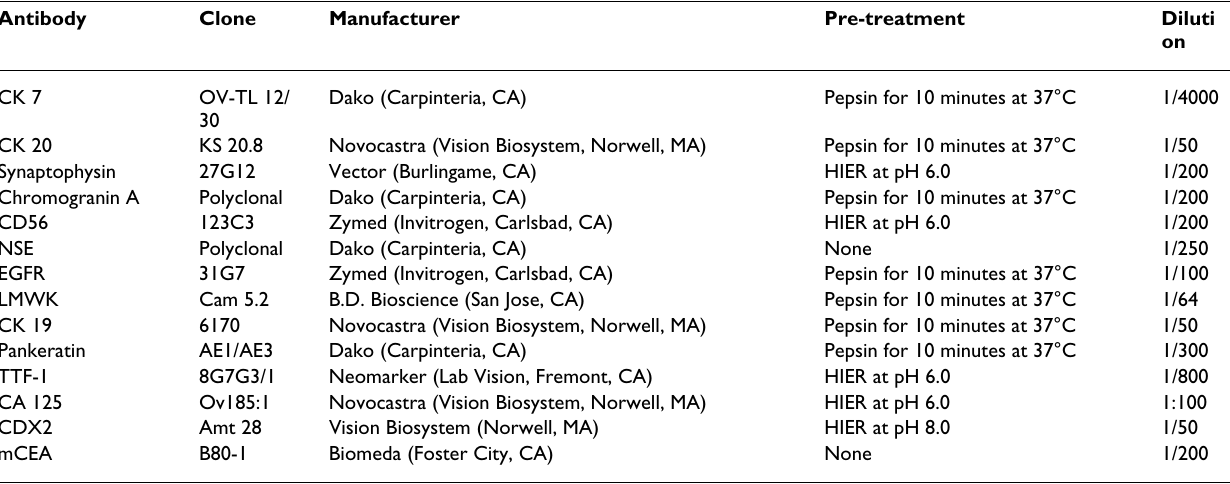
Table 1: The panel of immunohistochemical reagents used